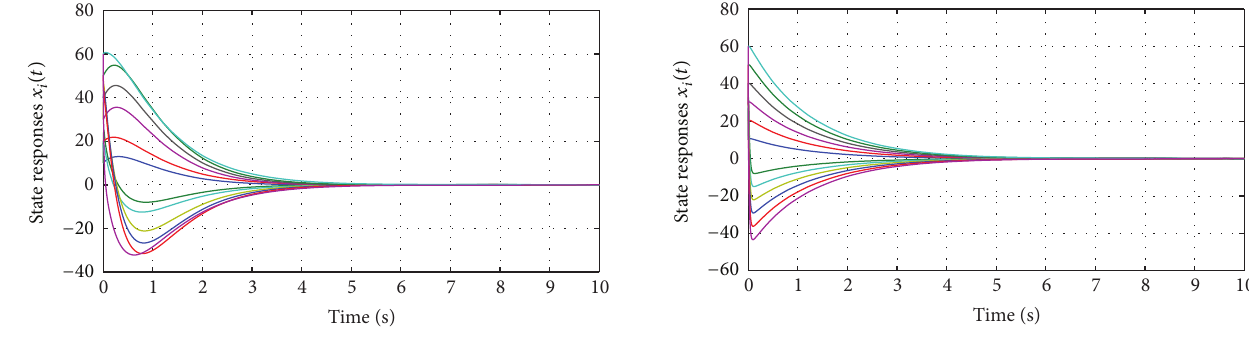
Figure 3: The state trajectories of six agents with topology G 2 .